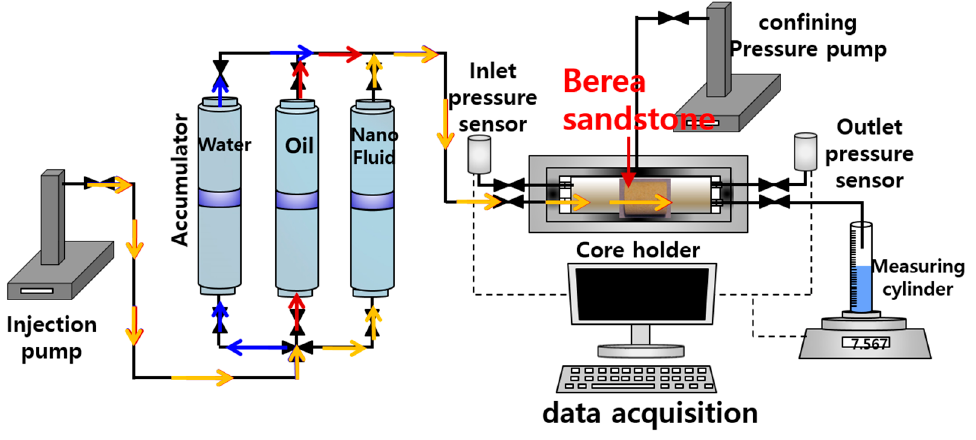
Figure 1. Schematic of the core flooding apparatus used to evaluate oil